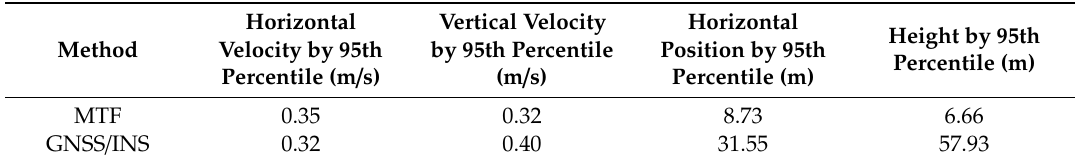
Figure 17. Clock error estimated by the MTF method and by GNSS alone. 4.3. Satellite Outage Case The vehicle travels in the satellite outage context for about 16 min (2300–3299 s). The position and velocity errors of the MTF method are shown in Figure 18. The position and velocity errors of the traditional GNSS/INS tightly coupled integration are shown in Figure 19. The errors of both methods increase over time, but that of the MTF method is much slower. In addition, the height error does not grow over time. The error statistics are shown in Table 6. The errors are characterized by the 95th percentile. Comparing the MTF method with GNSS/INS, the horizontal position errors of the two methods are approximately 15.52 m against 184.4 m, the height errors are approximately 5.34 m